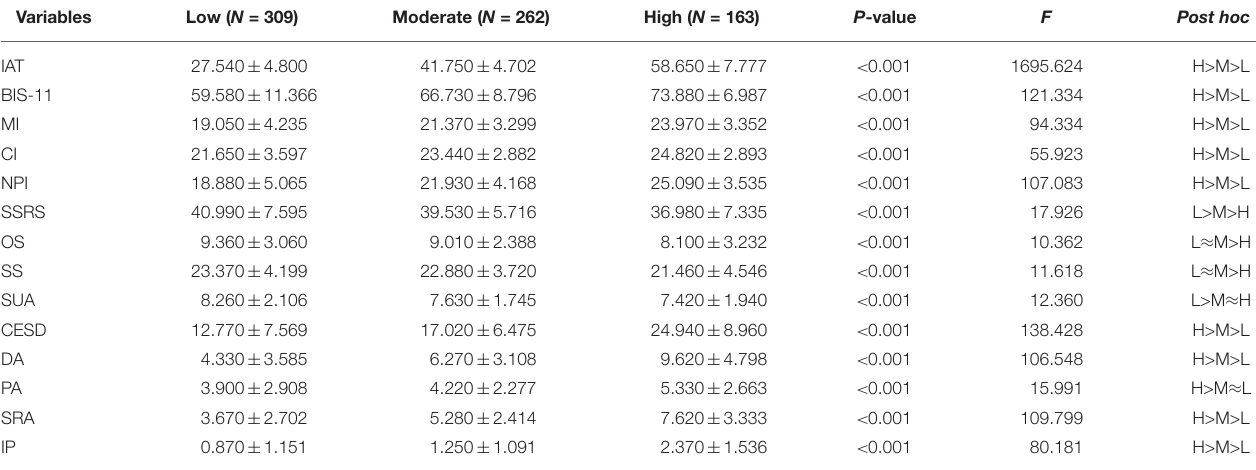
L, low internet addiction group; M, moderate internet addiction group; H, high internet addiction group.